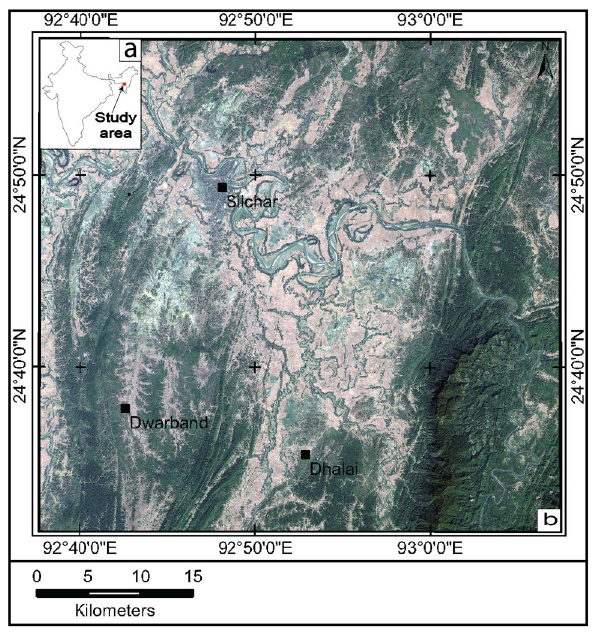
Fig. 1 a Geographical location of the study area, b true color com- posite map of the study area formed by Landsat 7 ETM+ bands 3, 2 and 1 in RGB been exploited due to the poor understanding of the subsur- face structures (Chatterjee et al. 2006).